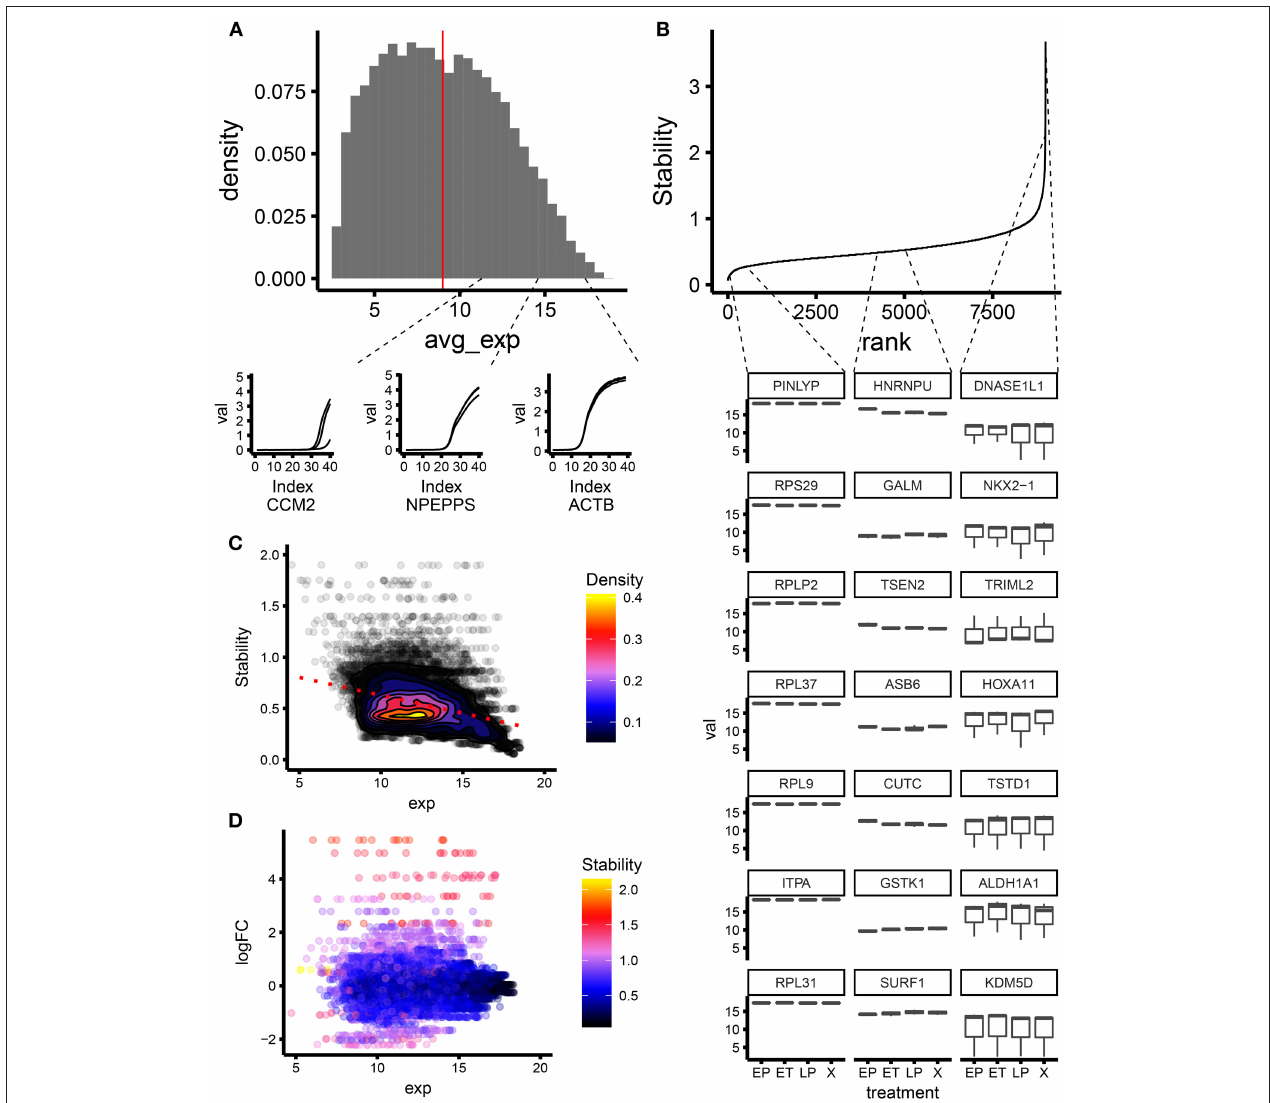
FIGURE 1 | Screening for stable genes using geNorm on microarray data for an investigation of ECFC senescence. (A) Distribution of normalized gene expression from microarray data. The red line defines the arbitrary threshold used to filter the dataset. In the lower panel, the qPCR amplification plots for some genes along the distribution are shown. Genes with expression level close to the threshold are close to the LOD of our experimental setup. (B) Stability vs. ranking obtained from geNorm. In the lower panel, the distributions of expression levels (from the microarray) for some genes along the ranking are shown. Genes with lower rank have higher within and between treatment variability in gene expression. (C) Scatter plot of stability vs. expression (from microarray). The dotted line shows the trend in the dataset; genes with a higher expression level seem to have a lower stability score i.e., more stable. (D) MA plot showing level of expression vs. expression fold change. GeNorm stability score depicted using a colored